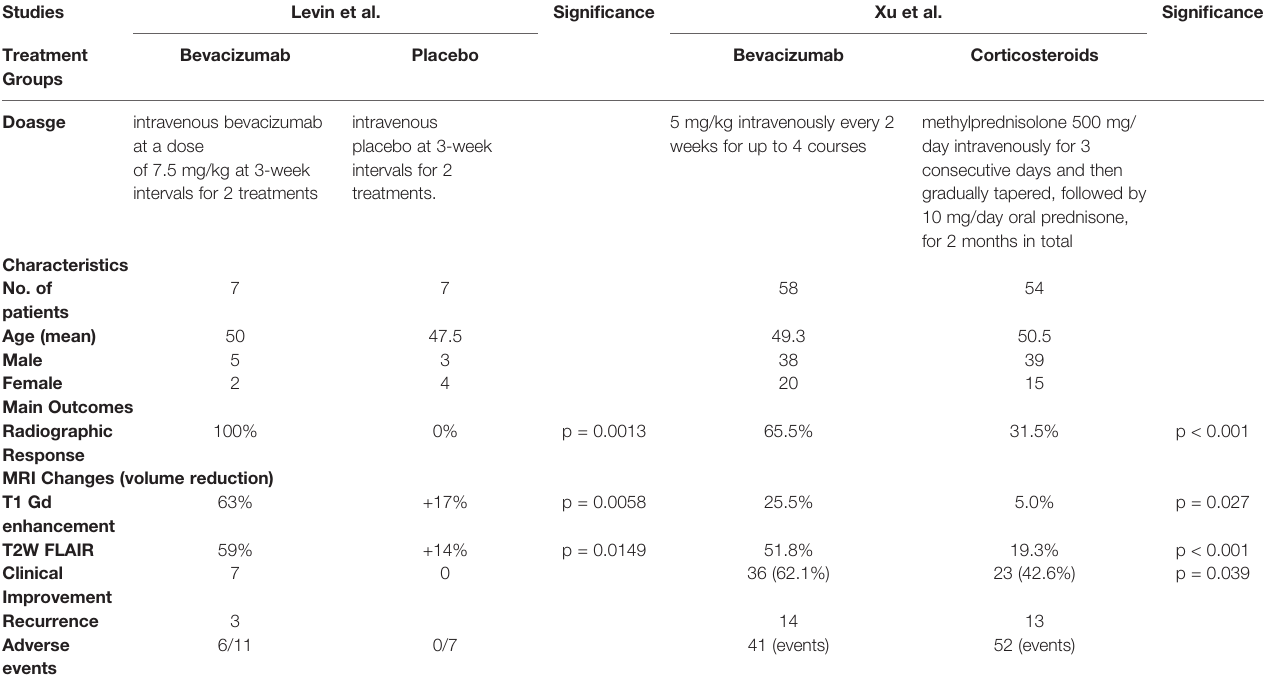
TABLE 2 | Comparison of bevacizumab and corticosteroid-based treatment of radiation induced necrosis. Studies Levin et